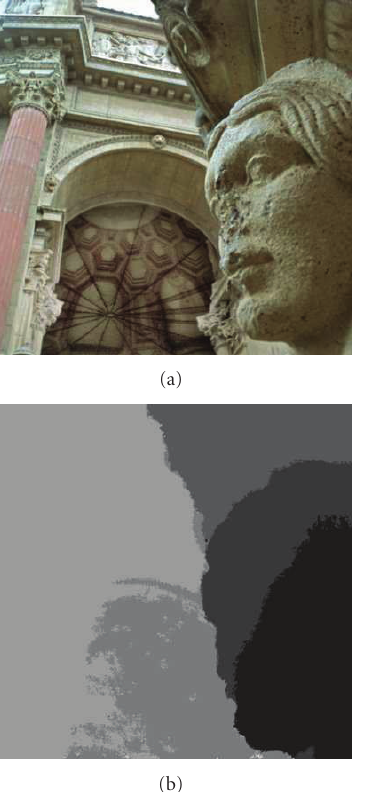
Figure 11: Super-resolved all-in-focus image and depth map of lightfield in Figure 10.